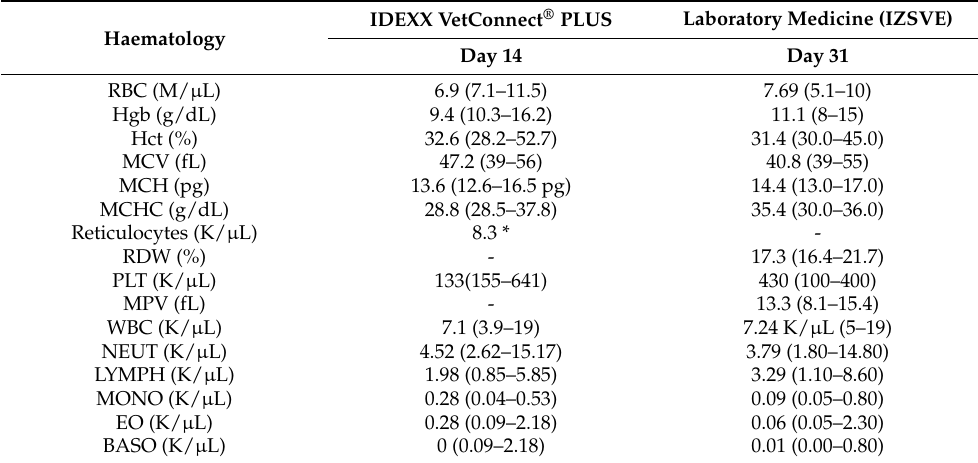
Table 1. Haematology performed from K3EDTA blood samples on Days 14 and 31, respectively. The first sample was analysed by IDEXX VetConnect ® PLUS Laboratories, and the second (Day 31) was performed at the SCS3 Laboratory Medicine of the IZSVE with the Sysmex XN1000-V analyser (Sysmex Europe GmbH, Norderstedt, Germany).